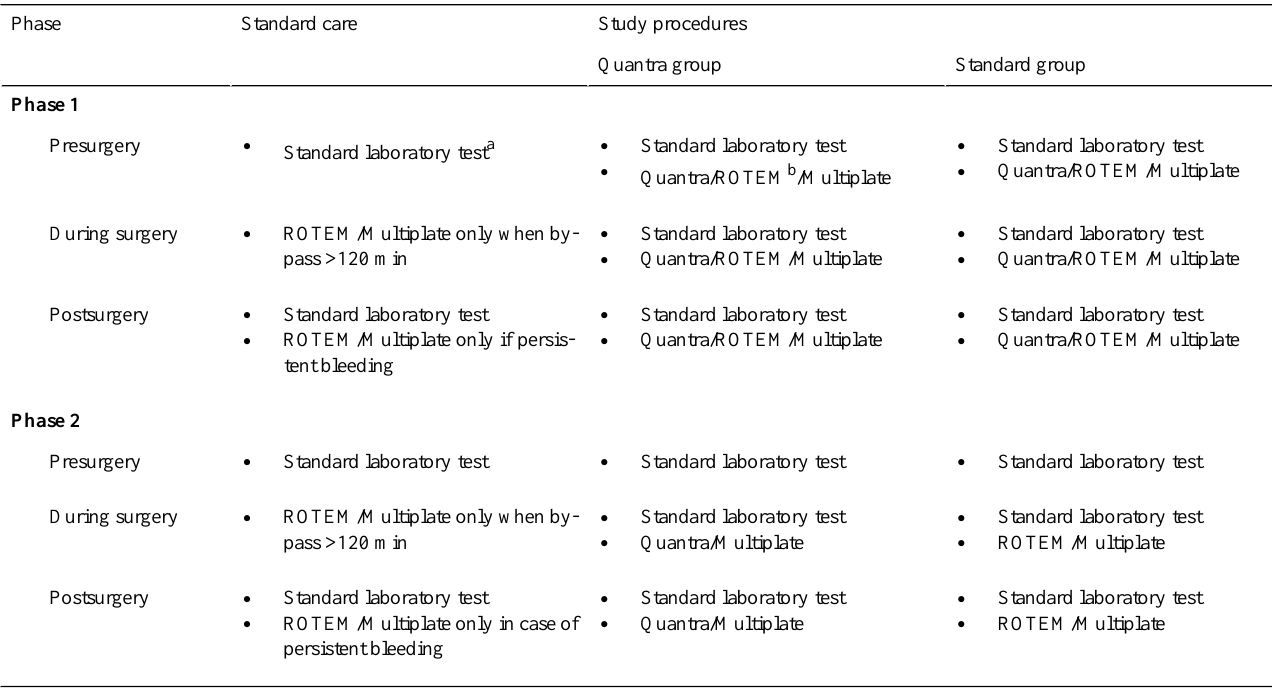
Table 2. Planned tests during the study compared to the previous standard in our